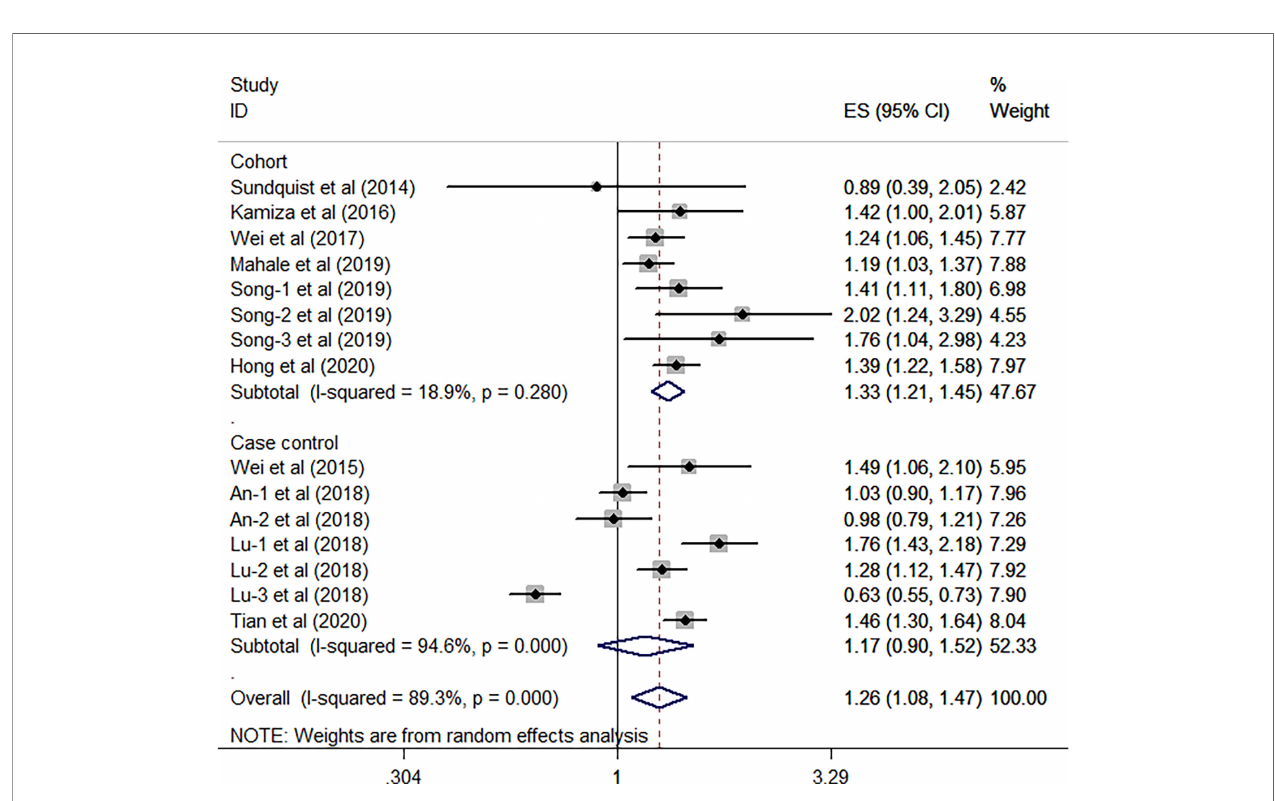
FIGURE 3 | Forest plots of the subgroup analysis (study design) on the association between HBV and gastric cancer.